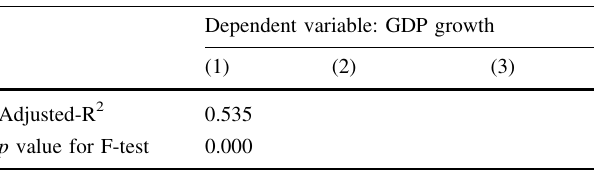
Table 5 Intraregional effects of meteorological disasters on